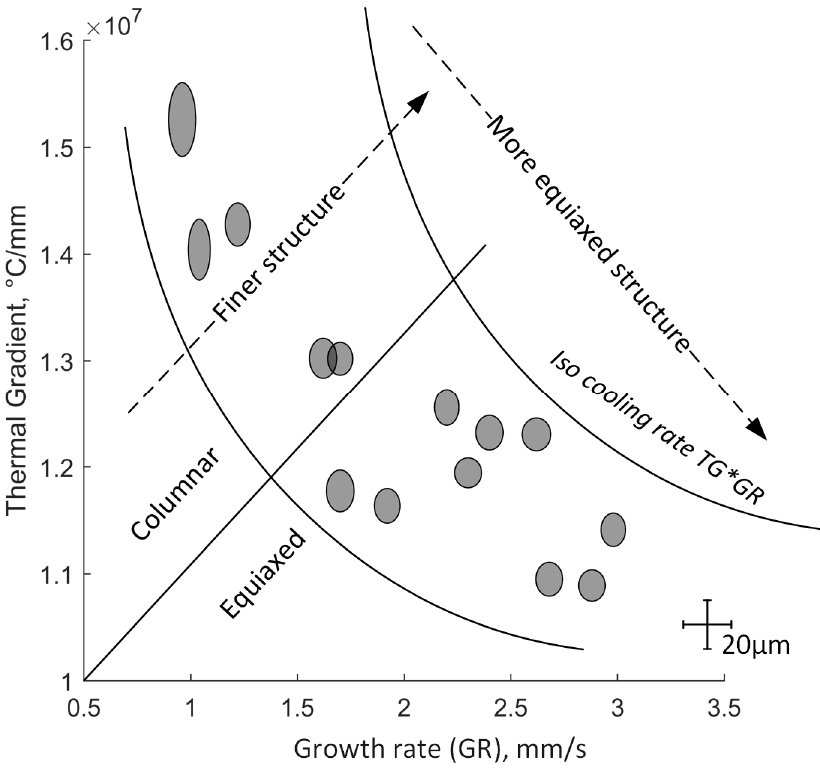
Figure 12. Grain morphology of LPBF iron as a function of the grain growth rate and the thermal gradient (idea of such a diagram is adopted from [39]).